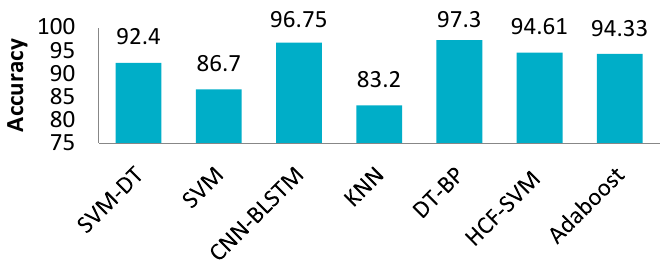
Figure 3. Comparison of motion mode recognition accuracy for different methods.